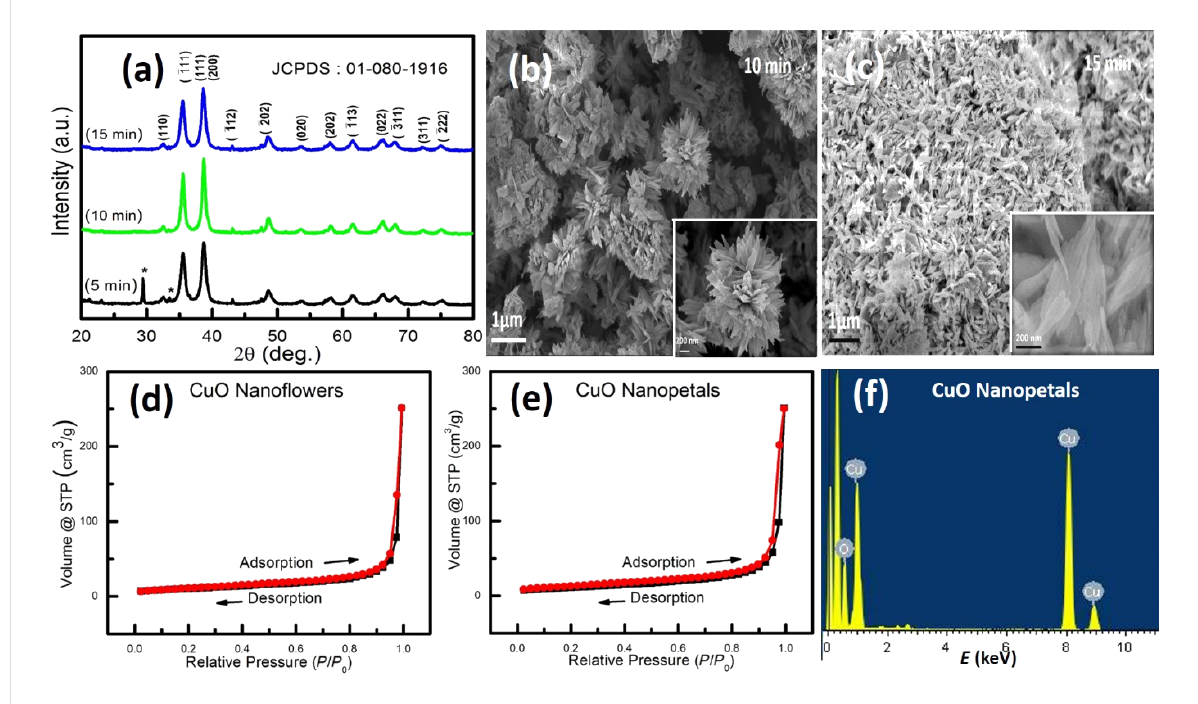
Figure 1: (a) XRD patterns of CuO nanomaterials synthesized by varying the reaction duration of 5 min, 10 min, and 15 min. FESEM images of CuO nanostructures obtained for the synthesis duration of (b) 10 min and (c) 15 min. The scale bar for the insets in (b, c) is 200 nm. Nitrogen adsorption–desorption isotherm for (d) CuO nanoflowers and (e) CuO nanopetals measured at 77 K. (f) EDAX spectra of CuO